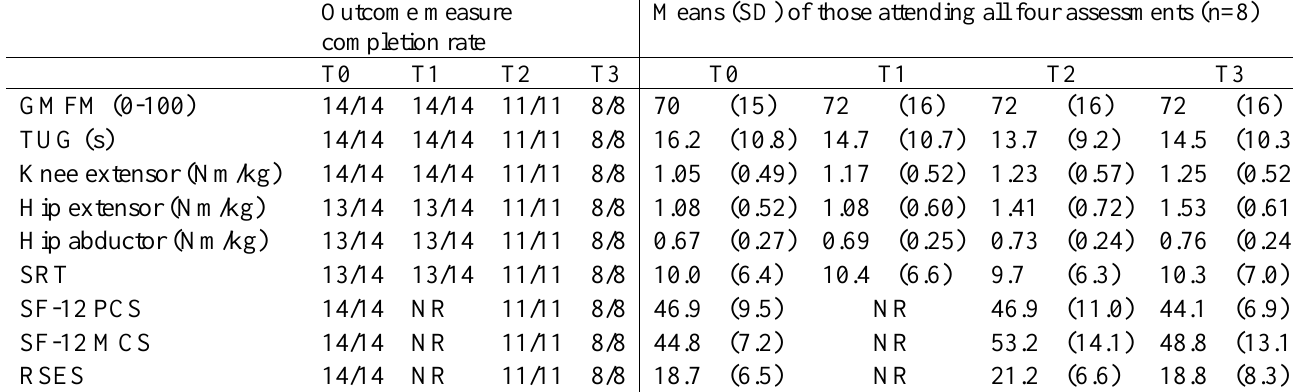
Table 3 Outcome measure completion rate (number of outcome measures completed/ number of participants attending for the assessment) and values (Mean and SD) at each assessment